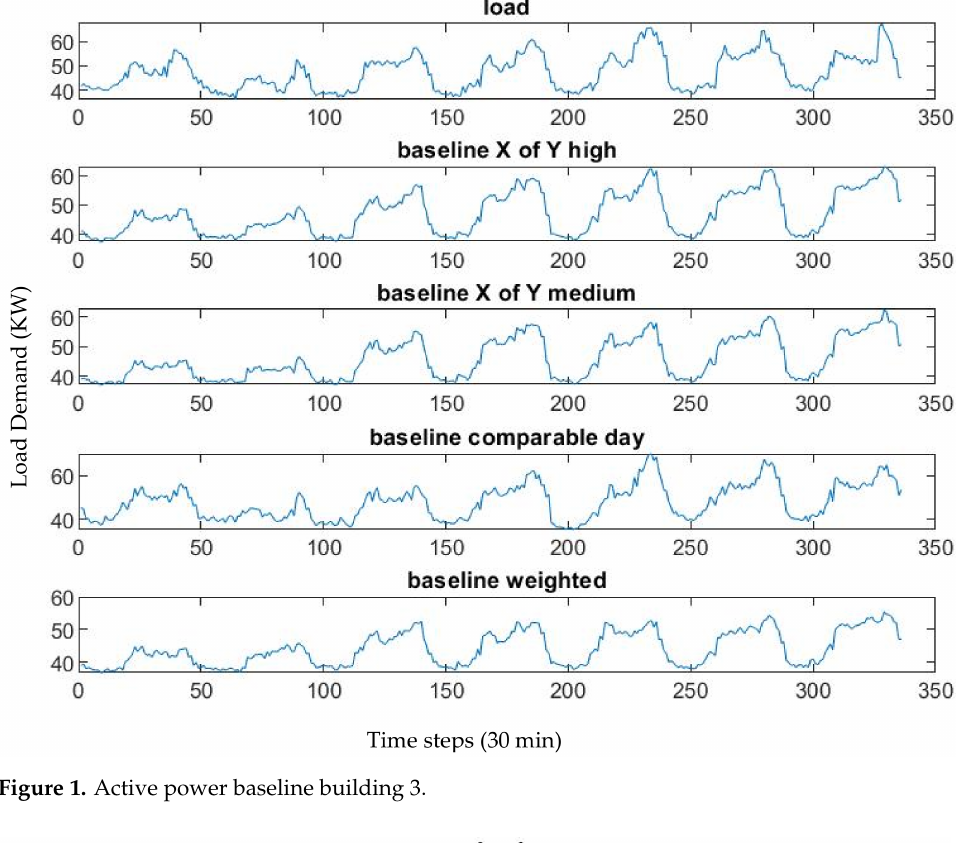
Figure 1. Active power baseline building 3.